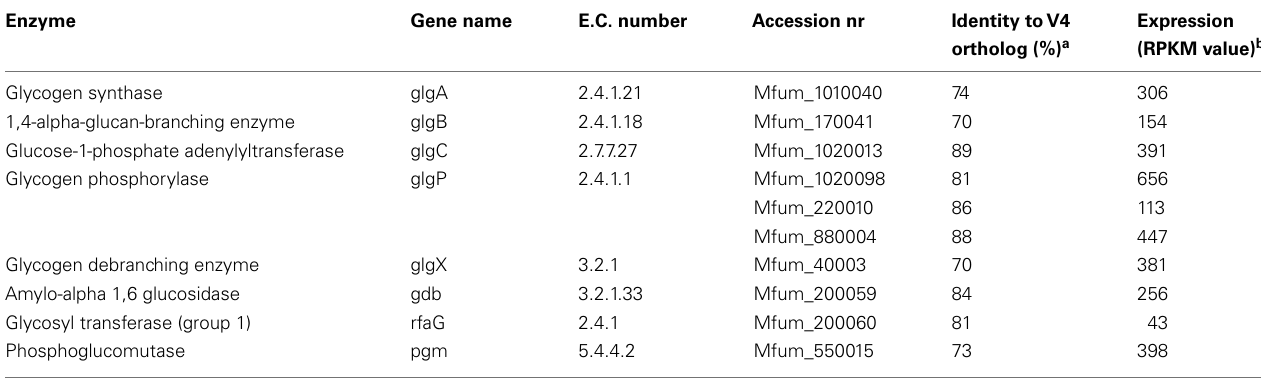
Table 2 | Genes involved in glycogen synthesis and degradation in M. fumariolicum strain SolV and their expression levels. Enzyme